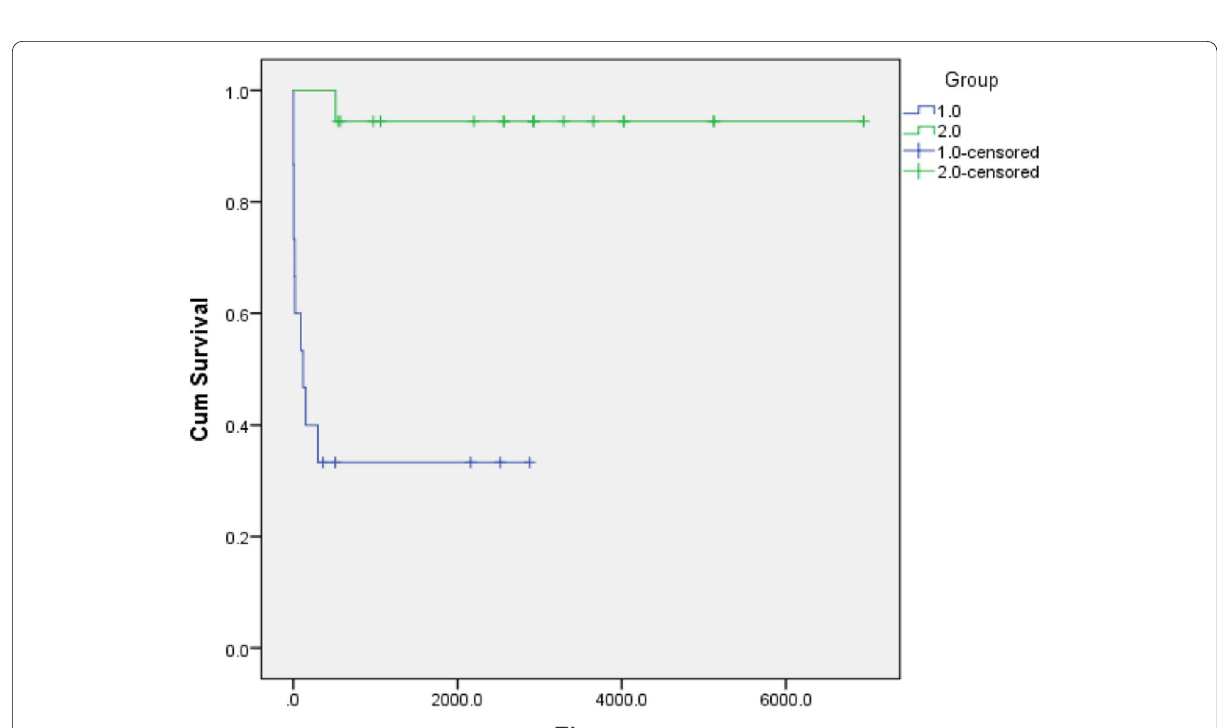
Fig. 2 Cumulative survival plots for